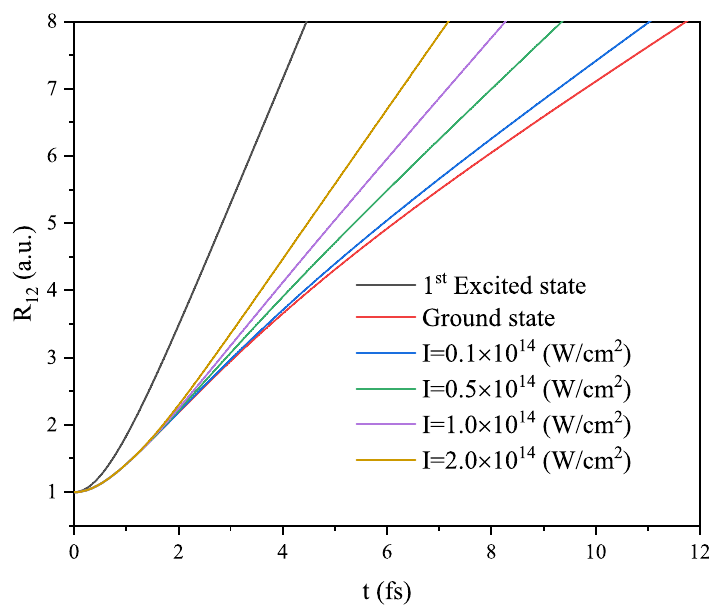
Figure 6. Considering classical nuclear dynamics, the inter-nuclear distance in the ground state of an ultra-short laser-induced H + became faster, increasing from 1 to 8 a.u., compared with when there was 2 no laser (red line). The results are also compared to the fastest, which is related to the first excited state of the system in the absence of a laser field (black